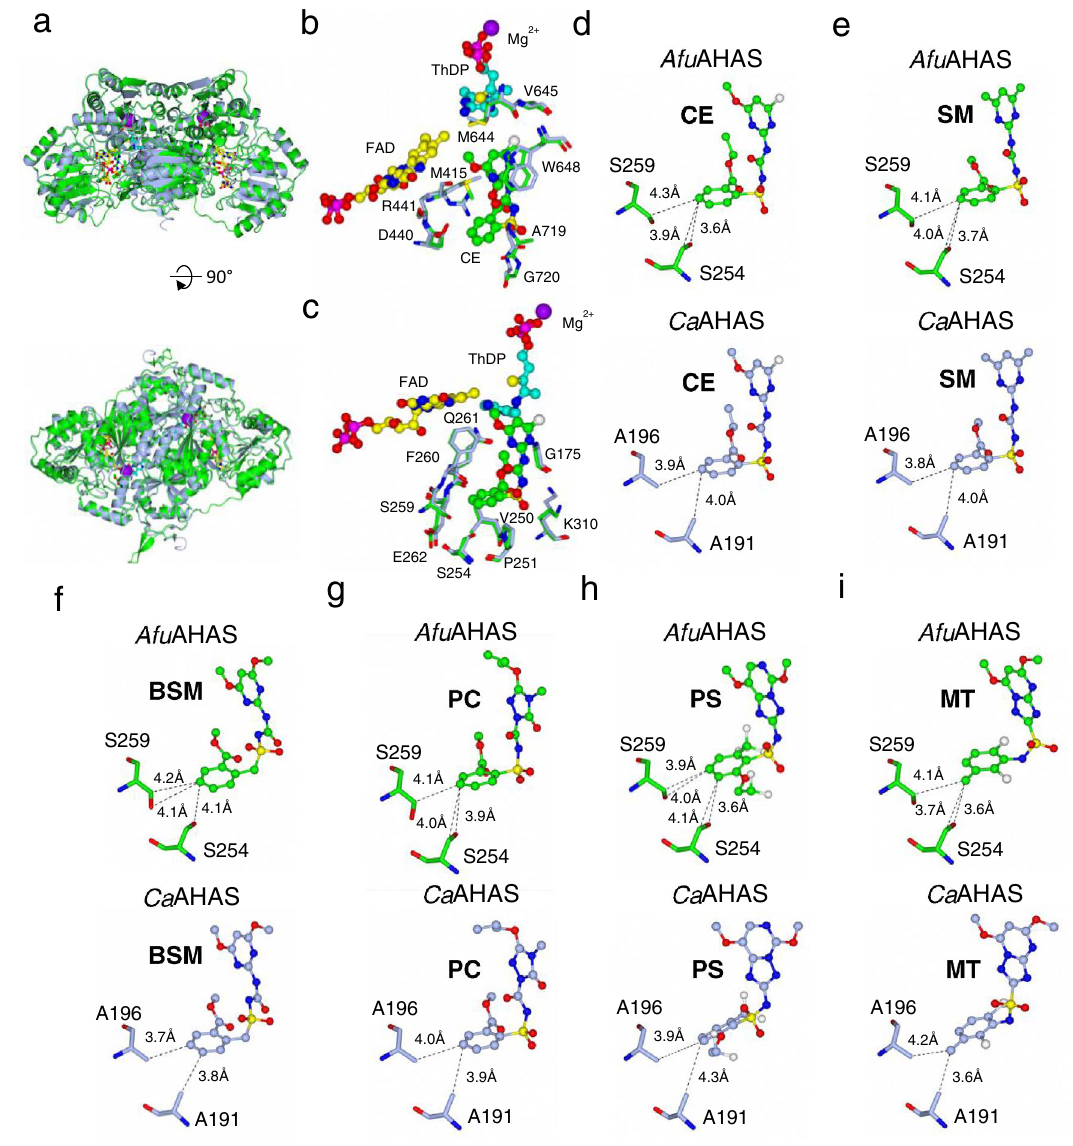
Figure 5. Structural comparisons of Afu AHAS and Ca AHAS. ( a ) The overall structure of the Afu AHAS homology model (green) superimposed onto the crystal structure of Ca AHAS (light blue). ( b , c ) The herbicide binding sites in Afu AHAS and Ca AHAS. Residues that make up the binding site from the two different subunits are shown separately in panels ( b ) and ( c ). ( d–i ) Comparison of CE, SM, BSM, PC, PS and MT binding to S254 and S254 in the Afu AHAS model and A191 and A196 of Ca AHAS in the crystal structures (PDB IDs for the structures of the complexes are 6DEL, 6DEP, 6DEM, 6DES, 6DEQ and 6DER, respectively). The herbicides, thiamine diphosphate and flavin adenine dinucleotide are shown as ball and stick models with the carbon atoms in blue or green for the herbicides and protein and cyan and yellow for thiamine diphosphate and flavin adenine dinucleotide. The magnesium ions are shown as purple spheres. The amino acid side-chains are shown as stick models. The dashed lines represent distances between the two atoms, not necessarily bond formation. The images were prepared using CCP4mg 22